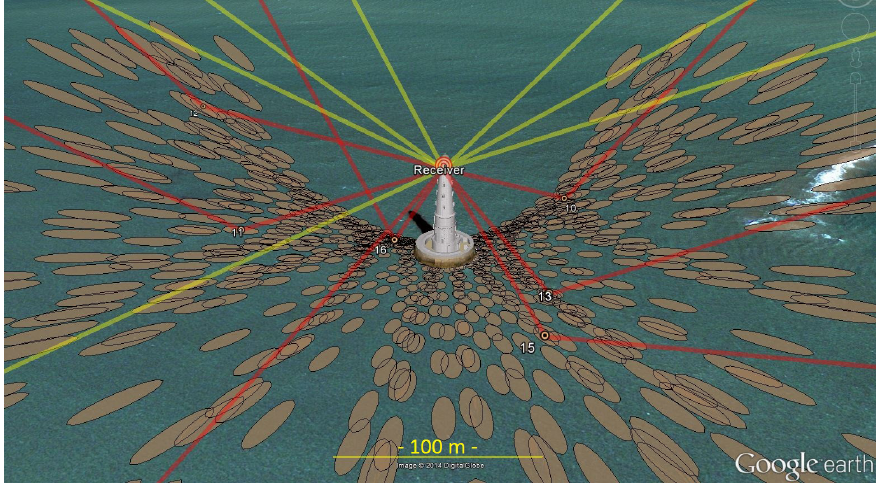
Figure 8. First Fresnel zones and some direct and reflected waves displaying the 24h Cordouan lighthouse simulation with the GPS constel-